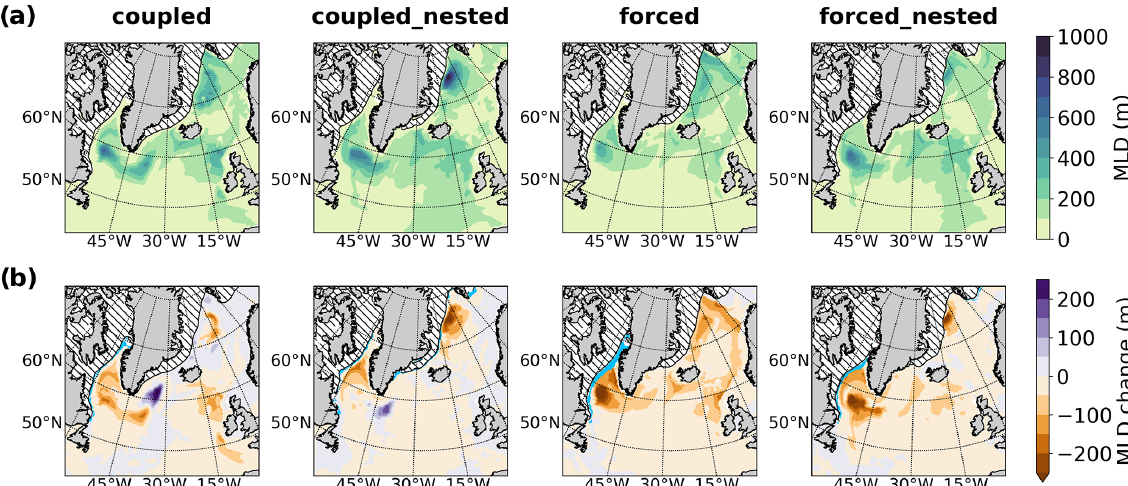
Figure 7. (a) Long-term mean state of annual-mean mixed-layer depth and (b) the change in consequence of the freshwater perturbation. The response is computed as the difference in the means over years 51–100 and 43–62 in the coupled and forced cases, respectively. Sea-ice coverage (ice concentration > 15%) in the reference state is indicated by white areas with hatching, and sea-ice expansion in the perturbed state is bright